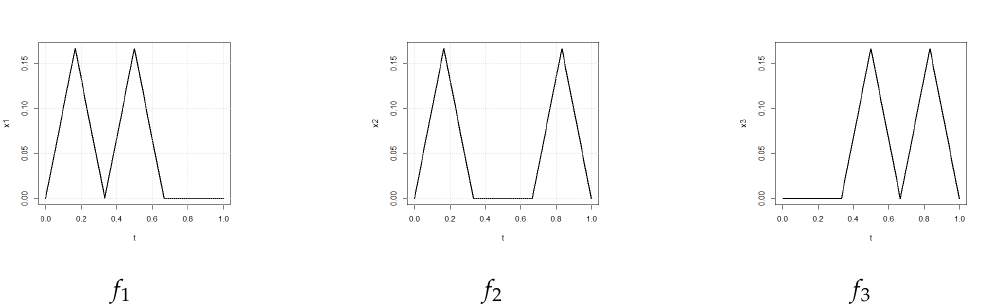
Figure 7. An example of functions f 1 , f 2 , f 3 such as the pairs ( f 1 , f 2 ) , ( f 2 , f 3 ) , ( f 3 , f 1 ) have leader, but the vector ( f 1 , f 2 , f 3 ) has no leader